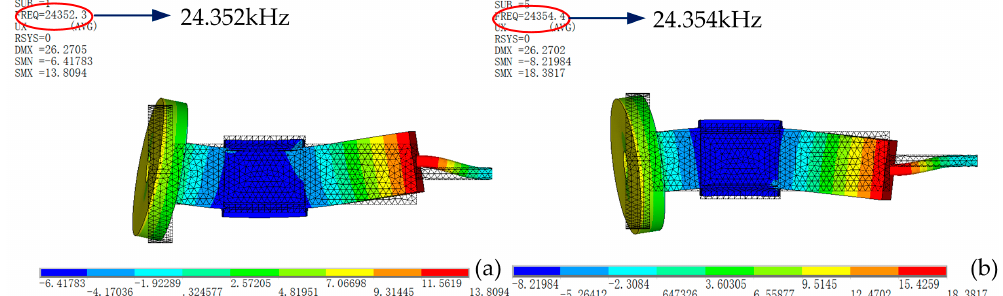
Figure 3. Vibration modes by modal analysis: ( a ) Vertical bending mode; ( b ) Horizontal bending mode.